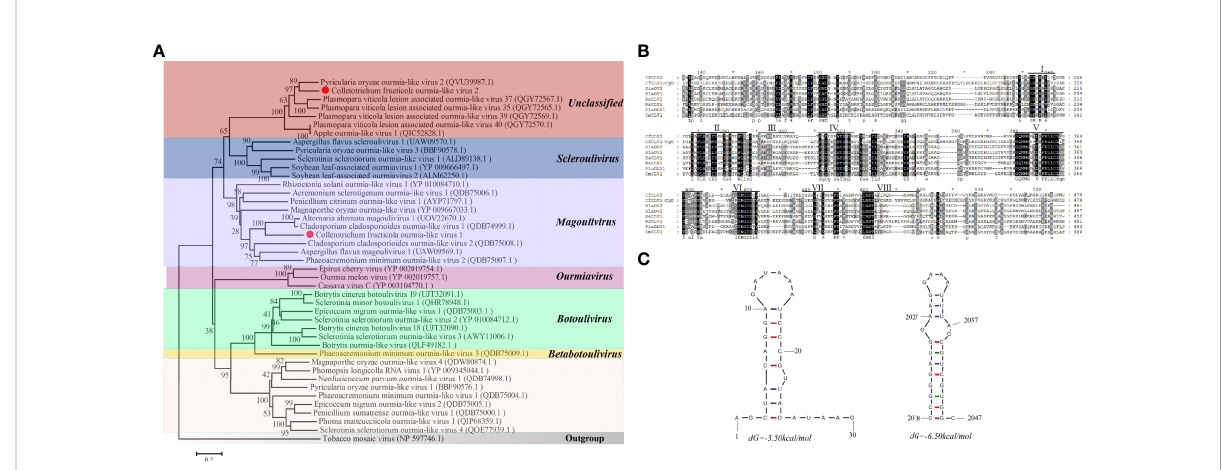
FIGURE 2 Phylogenetic tree, conserved motifs, and secondary structure prediction of CfOLV2. (A) A phylogenetic tree was constructed based on the amino acid sequences of RdRp using the neighbor-joining method in MEGA 6.0. Tobacco mosaic virus was used as an outgroup. The scale bar represents a genetic distance of 0.2 amino acid substitutions per site, and the red dots indicate the positions of CfOLV1 and CfOLV2. (B) Amino acid sequence alignment of the RdRp motifs and other selected ourmia-like viruses. The conserved motifs are indicated by Roman numbers. (C) Stem − loop structures could be predicted in the 5 ’ and 3 ’ UTRs of CfOLV2 with D G values of -3.50 and -6.50 kcal/mol, respectively.